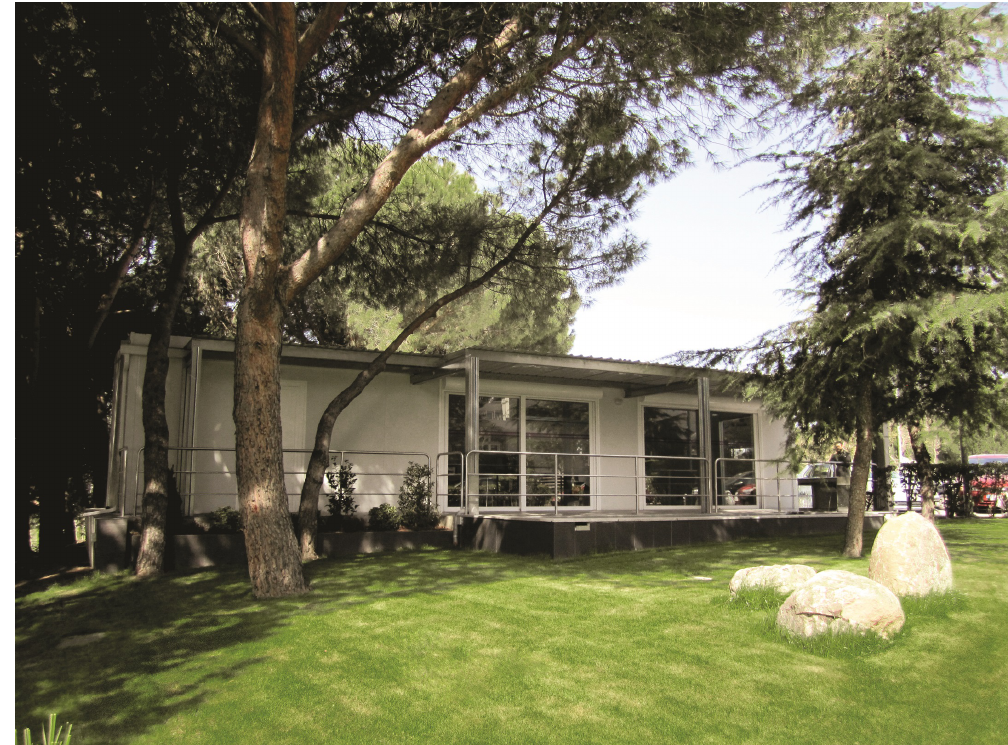
Figure 1. The Smart House Living